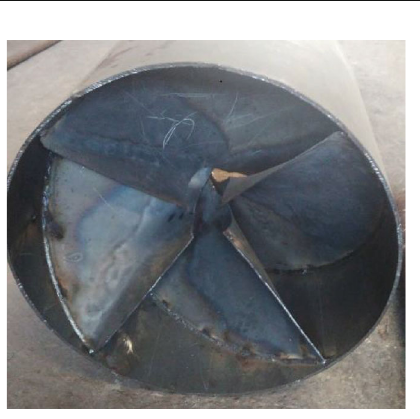
Figure 19: Arrangement of spiral blades in the experimental